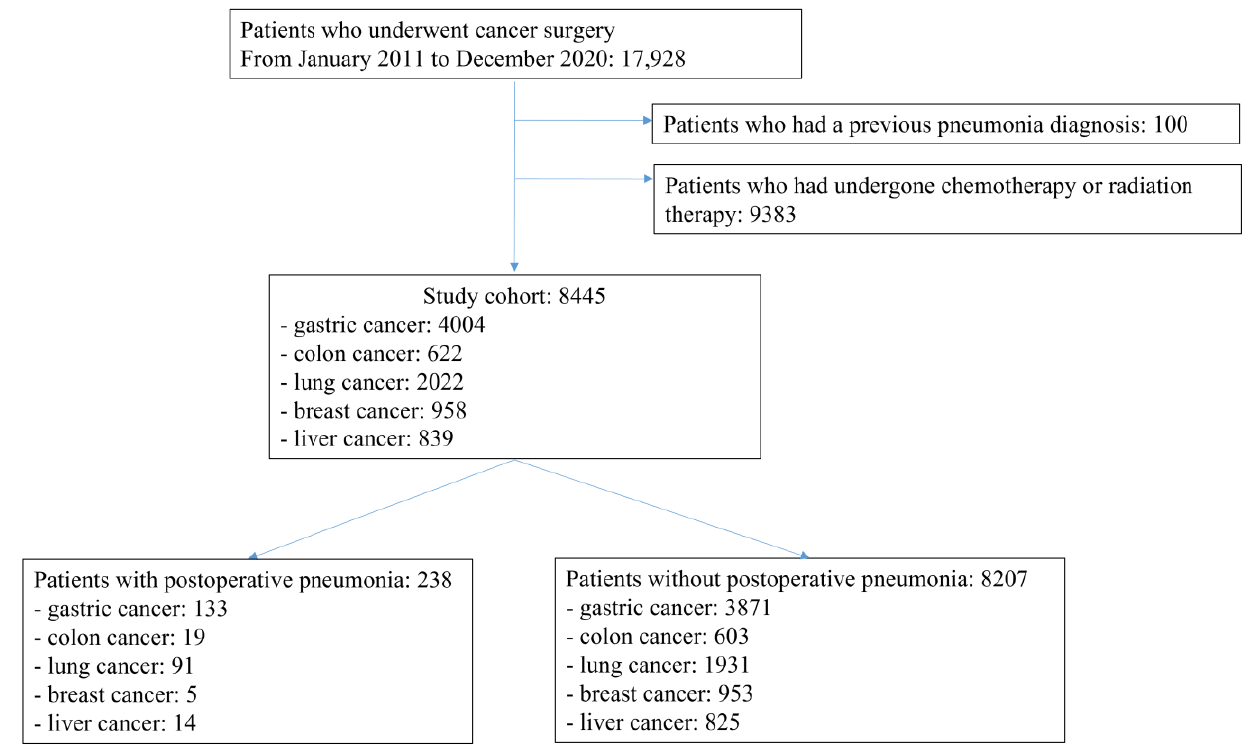
Figure 1. Flow diagram of the study.